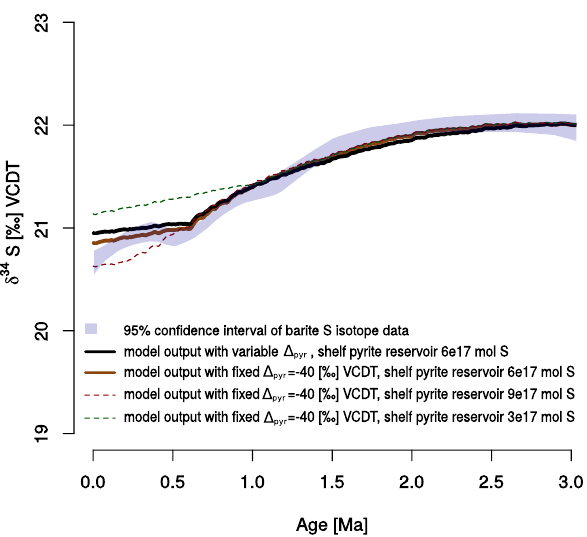
Figure 5. Model output – seawater sulfate δ 34 S value. Brown solid line – model output with constant offset of − 40‰ between δ 34 S seawater and δ 34 S pyrite values. Grey solid line – model output with variable offset between δ 34 S seawater and δ 34 S pyrite values (see Fig. 3). Red dashed line – model output with constant (cid:49) pyr off- set and 50% larger shelf pyrite sub-reservoir. Green dashed line – model output with constant (cid:49) pyr offset and 50% smaller shelf pyrite sub-reservoir. The shaded area is the 95% confidence interval of a LOESS approximation of the “true” δ 34 S SO 4